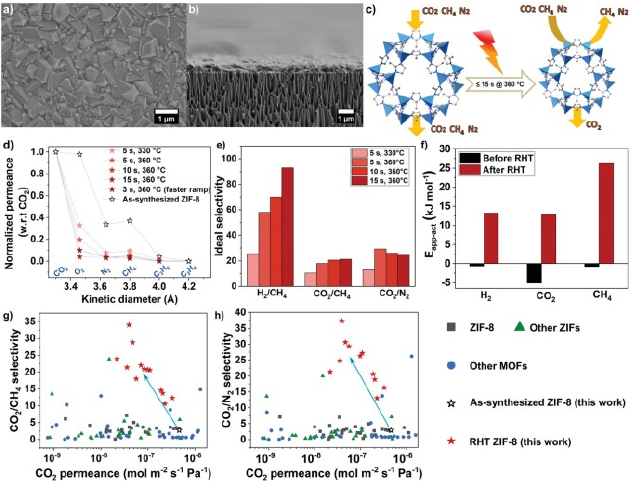
Figure 21. Scanning electron microscopy images of the as-synthesised ZIF-8 membrane: ( a ) top view and ( b ) cross-sectional view. ( c ) Schematic representation of the rapid heat treatment (RHT) process. ( d – h ) Gas separation properties of RHT ZIF-8 membranes: ( d ) gas separation characteristics of ZIF-8 at 30 °C as a function of rapid heat treatment parameters. ( e ) Ideal selectivity for various gas pairs at 30 °C as a function of the dwell time and temperature. ( f ) The calculated apparent activation energy for ZIF-8 membrane before and after RHT. Comparison of the CO 2 separation performance of RHT ZIF-8 membranes with other reported MOF membranes: ( g ) CO 2 /CH 4 and ( h ) CO 2 /N 2 , arrow shows the improvement in the separation performance after RHT. Reprinted with permission from [208], Copyright (2019) John Wiley and Sons publications.